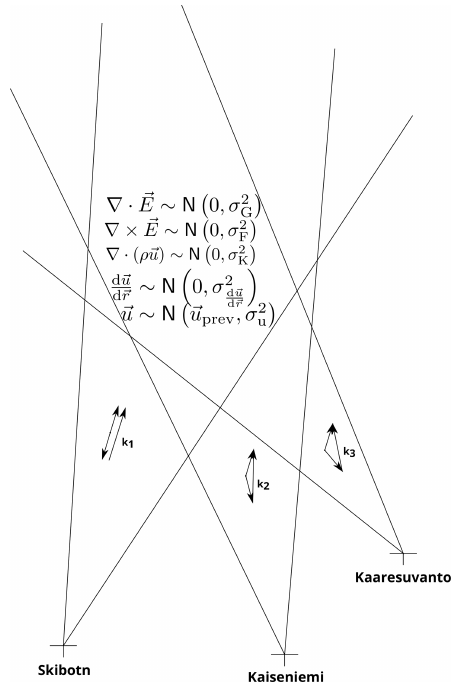
Figure 1. The figure shows geometry and assumptions on E3D vol- umetric measurements. The figure is not to scale or